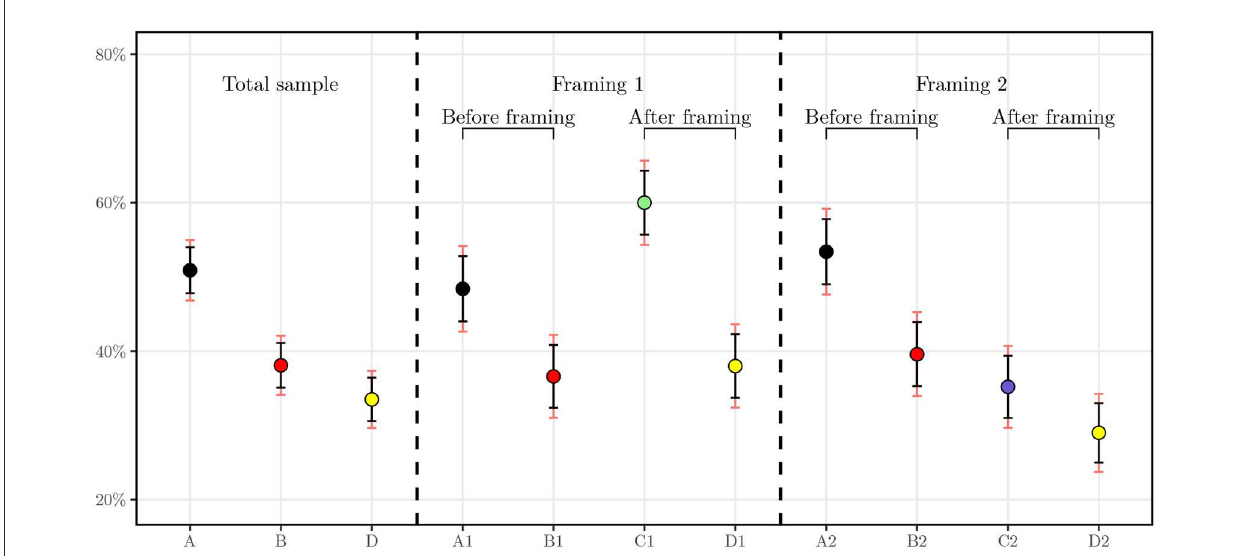
FIGURE2 Average level of agreement with 95 and 99% confidence intervals. A 1 and A 2 correspond to the level of agreement for question A in each subsample of N = 500, respectively. B 1 and B 2 correspond to the level of agreement for question B in each subsample of N = 500. C 1 and C 2 correspond to the level of agreement for question C in each subsample of N = 500.